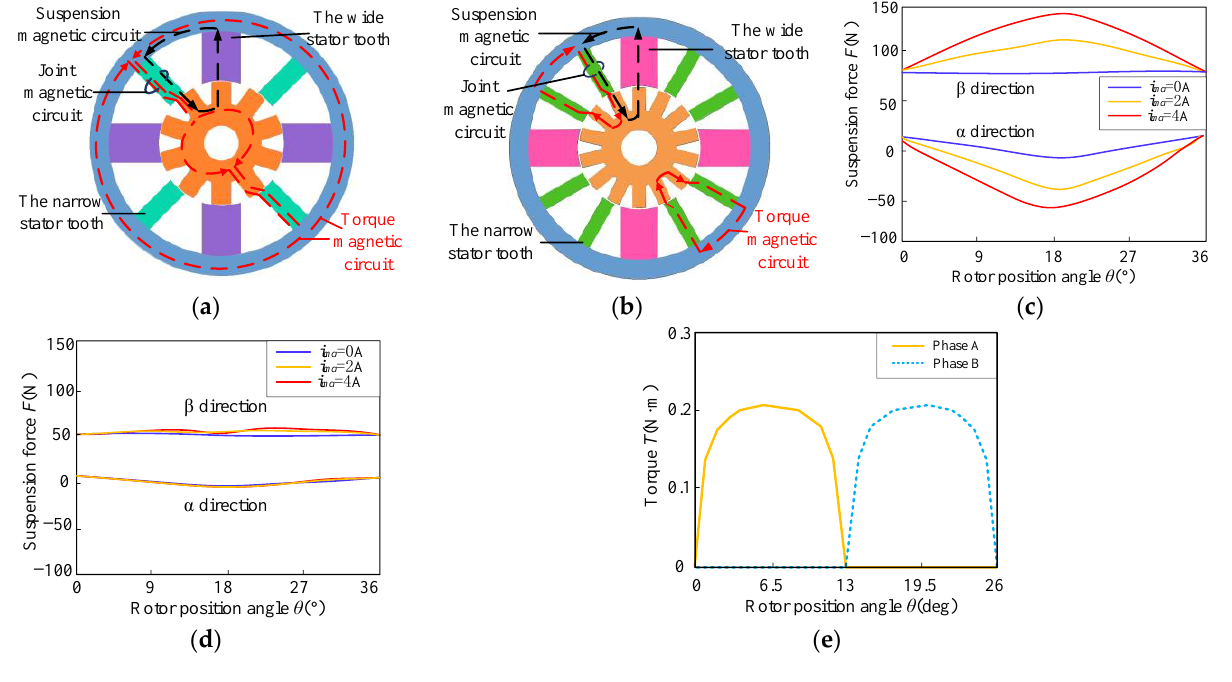
Figure 3. Common hybrid stator tooth BSRM: ( a ) 8/10 pole hybrid stator tooth structure; ( b ) 12/14 pole hybrid stator tooth structure; ( c ) Changing curves of F of 8/10 structure; ( d ) Changing curves of F of 12/14 structure; and ( e ) Torque characteristic curve of 12/14